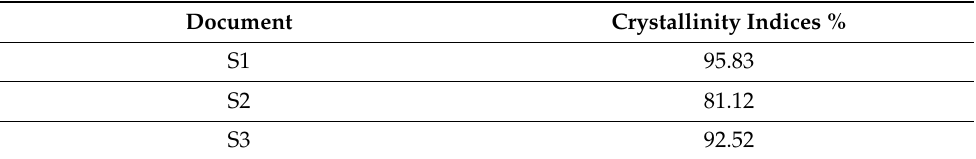
Table 3. Crystallinity indices calculated according to Raman